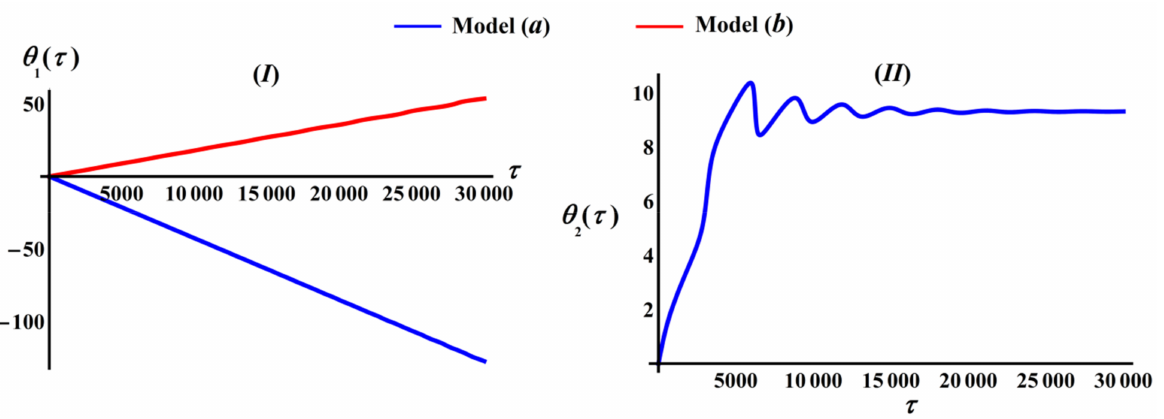
Figure 3. The variation of the modified phases: ( I ) θ 1 via time τ and ( II ) θ 2 via time τ .